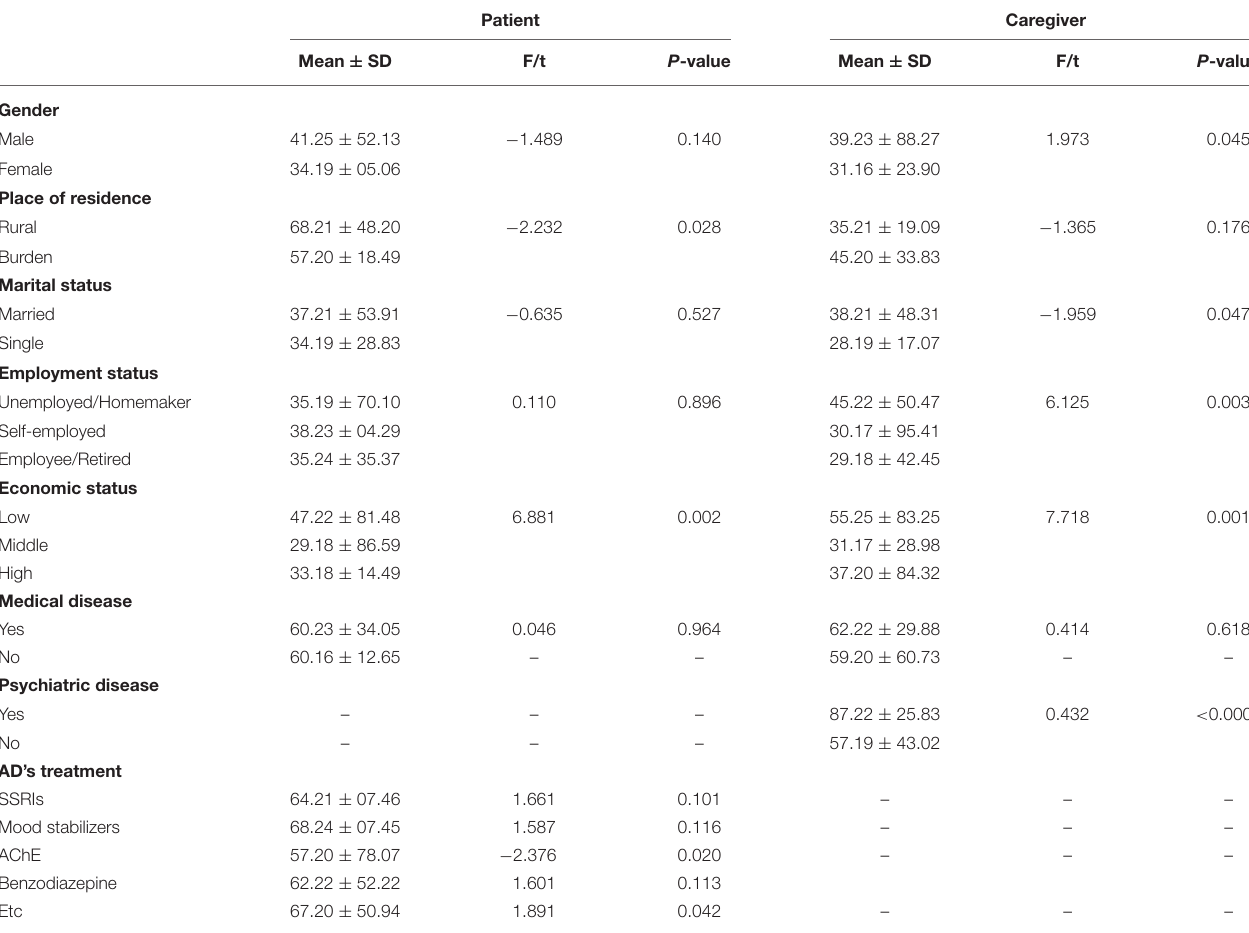
TABLE 5 | Descriptive and inferential results of the relationship between demographic variables and CB of caregivers of patients with Alzheimer’s disease (AD).